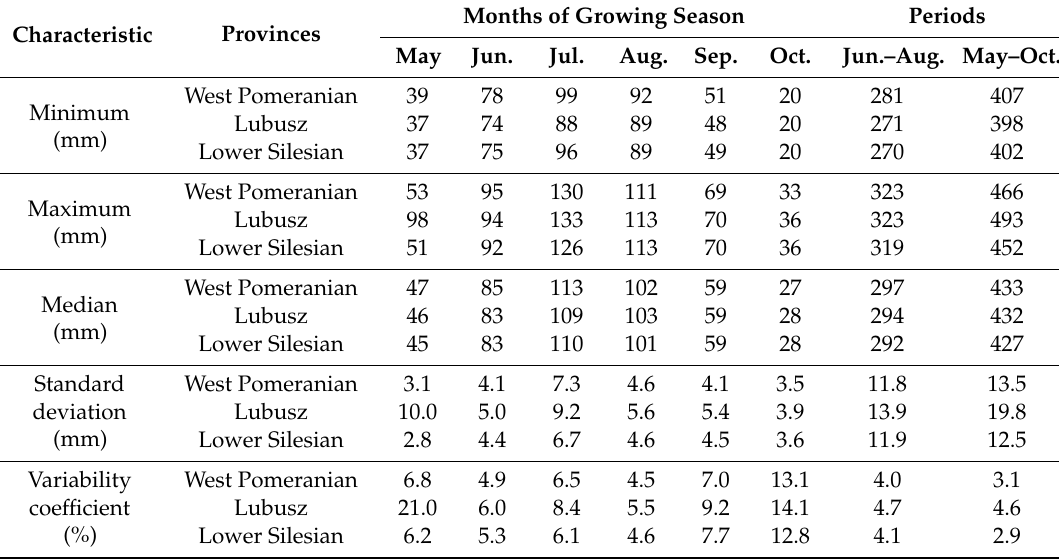
Table 3. Descriptive characteristics of grapevines water needs in the years 1981–2010 in three examined provinces in western Poland.